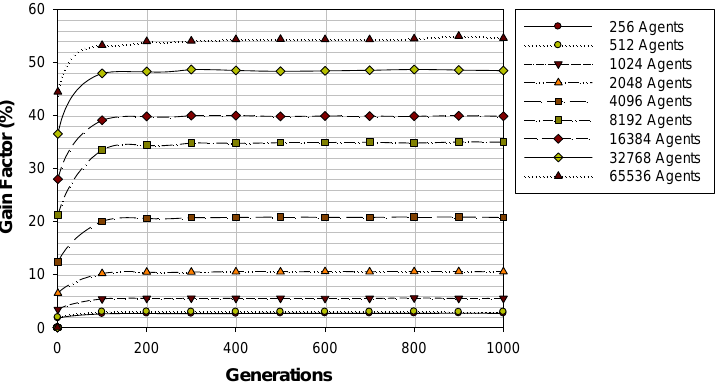
Figure 7. The factor obtained on the GPU with respect to the parallel CPU